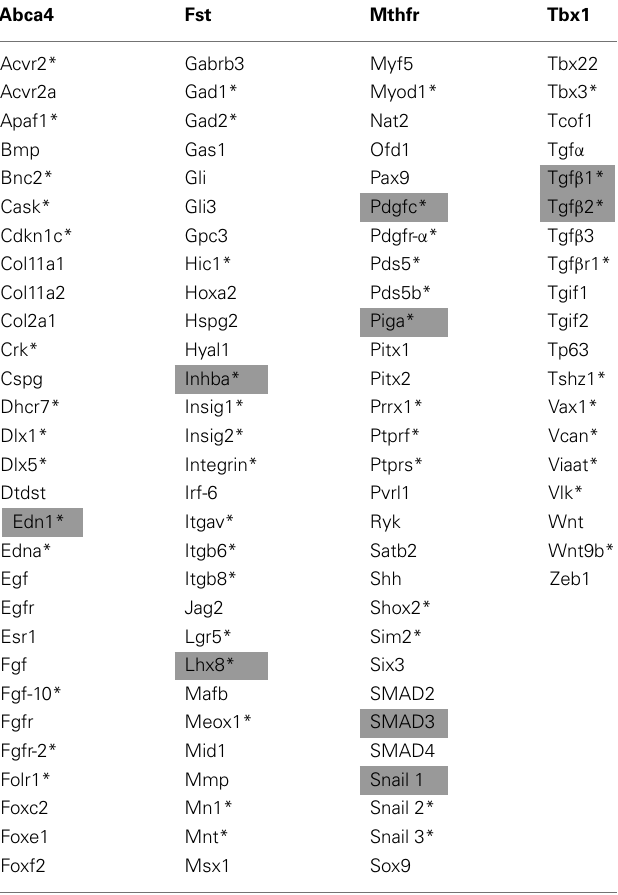
TableA2 | Genes susceptible for cleft